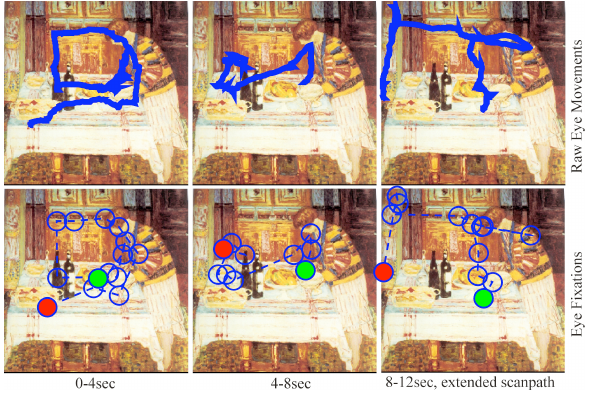
Figure 1. Bonnard’s "After the meal" (1925). Three consecutive eye movement recording show the extended scanpath for late artistic image acquisition. A woman in the upper left hand corner seems like entering the scene in a blurry and low contrast patch of colors and she is fixated only during the last scanpath. Raw eye movements are displayed in the top row. A parsing algorithm detected the eye fixations which are displayed with circle and connected by dashed line (saccades) in the bottom row; the first and the last fixation are marked with a green and a red circle respectively.